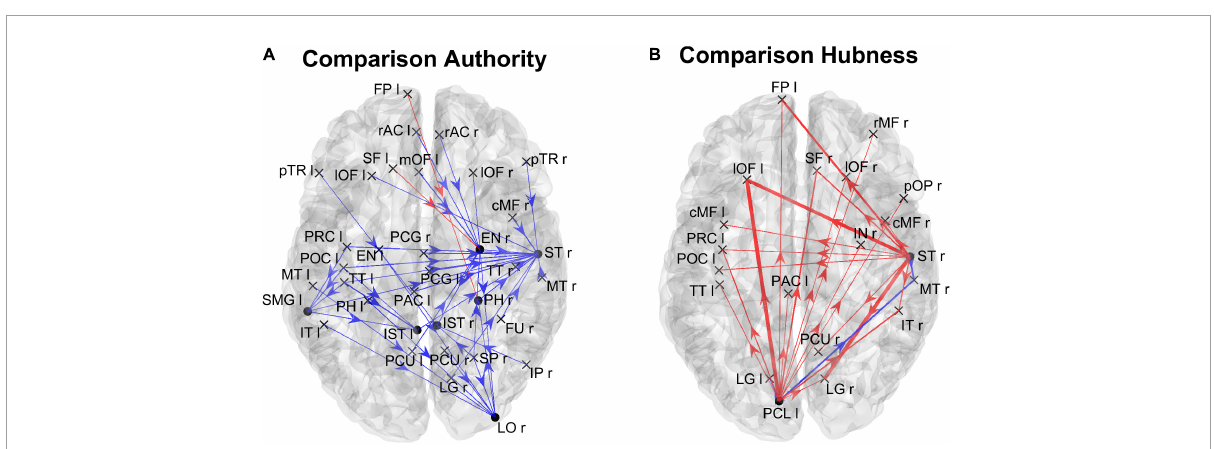
FIGURE3 Patterns of the main connection difference which exit from the ROIs with a significant correlation between authority and the AQ score [left panel (A) ] and which enters into the ROIs with a significant correlation between the hubness and the AQ score [right panel (B) ]. Blue lines denote correlation differences that are higher in the Low AQ score group, and red lines connections which are higher in the High AQ score group. Only connection differences higher than 0.015 on the complete connectivity matrix have been plotted. Three levels of thickness are adopted, with a larger thickness indicating a larger connectivity